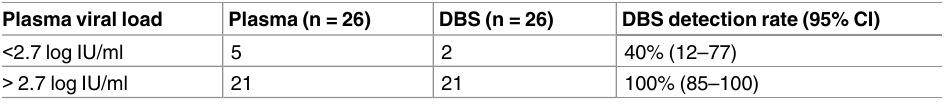
DBS, dried blood spots; CI, confidence